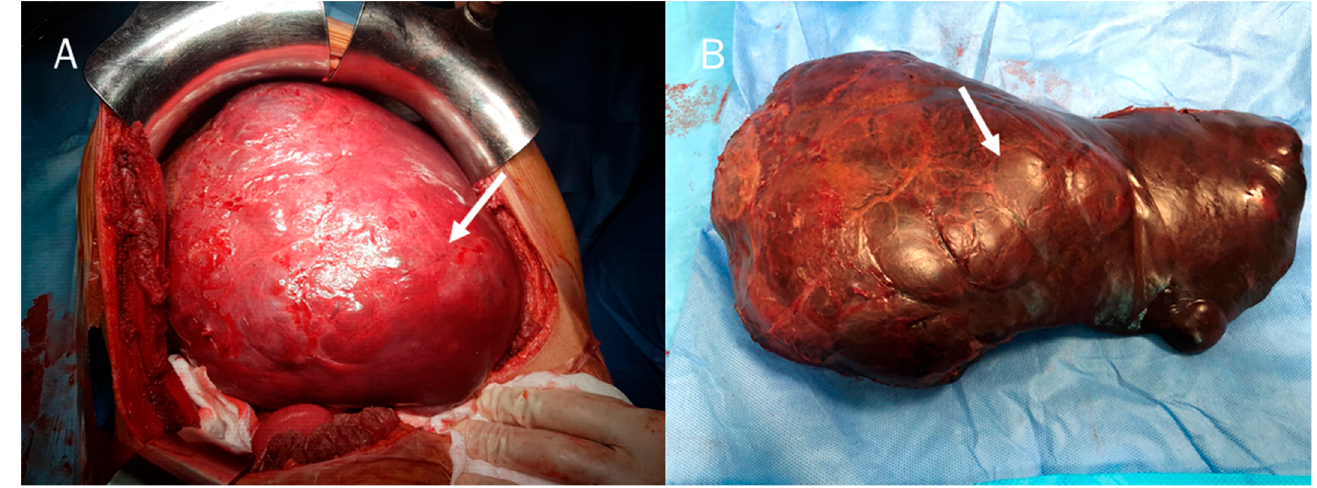
Figure 4. ( A ) cHCC ‐ CCA during surgical resection (arrow); and ( B ) in surgical specimen (arrow).